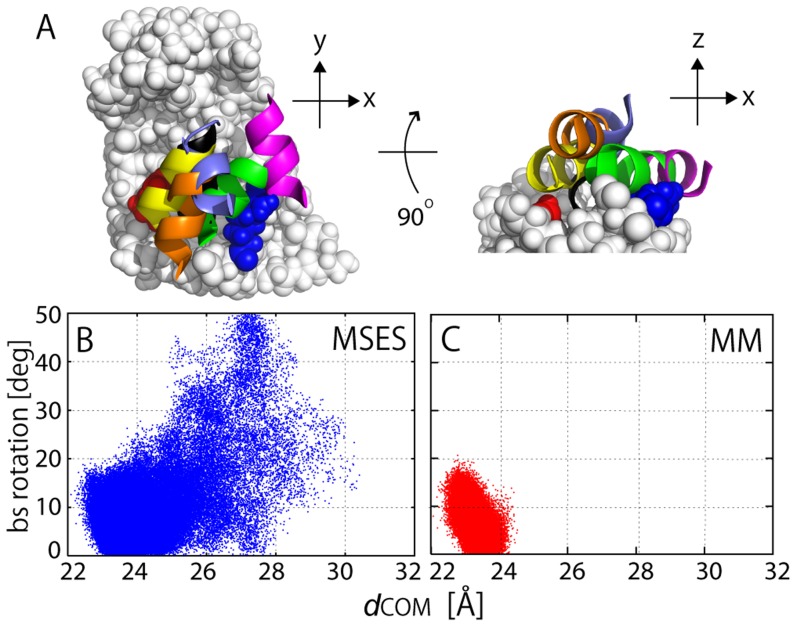
Downhill FES via shape complementarity.(A) Five snapshots of helix 3 (residues 34–42) of barstar for Q<0.1, together with helix 3 in native complex structure (black; in view from bottom). The white space filing model is barnase in which Arg59 (blue) and His102 (red) are colored in the figure. (B) and (C) 2D representation of FES along COM distance, d
COM, and rigid-body rotation angle of barstar from native complex structure, defined by change in direction of vector connecting Cα atoms of Asn33 and Asp83 between snapshot and native complex structure (see Fig. S3): (B) MSES simulation and (C) MM simulation.